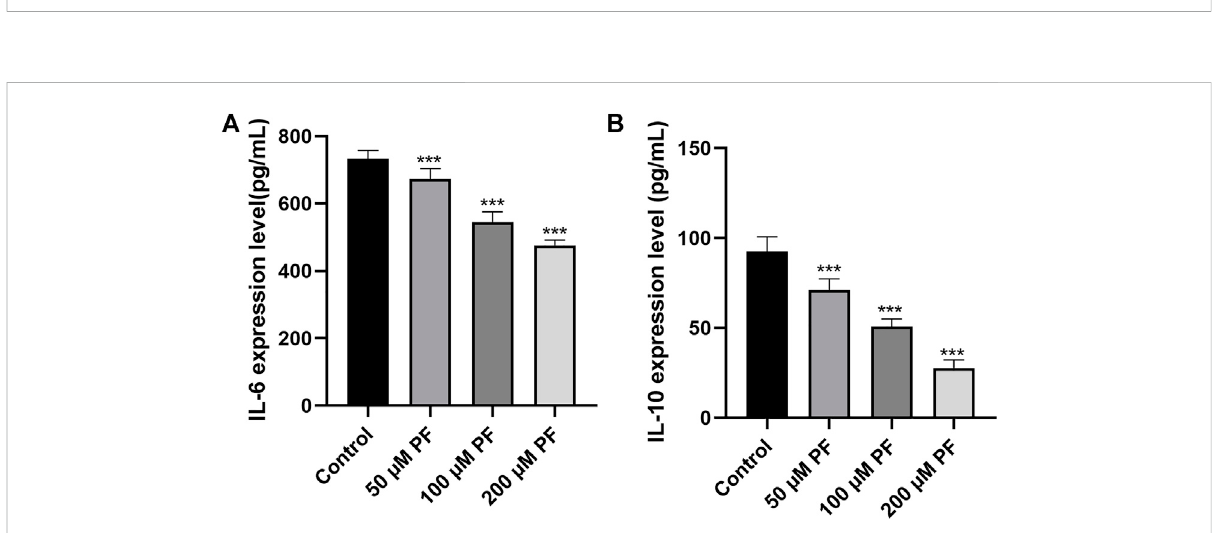
FIGURE 9 ThecontentsofIL-6andIL-10intheculturesupernatantofpancreaticcancercellsweredeterminedbyELISA. (A) IL-6expressionintheculture supernatant of PANC-1 cells. (B) IL-10 expression in the culture supernatant of Capan-1 cells. * p < 0.05; *** p < 0.001, versus control